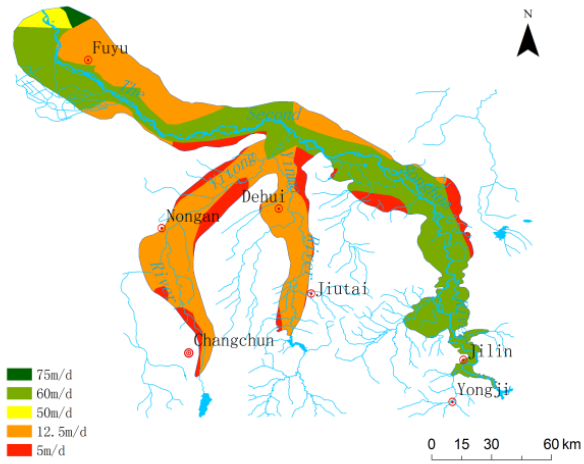
Figure 6. Distribution of hydraulic conductivity.